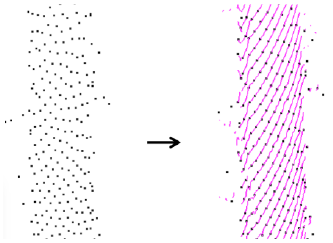
Figure 4. Point-cloud and scan-lines